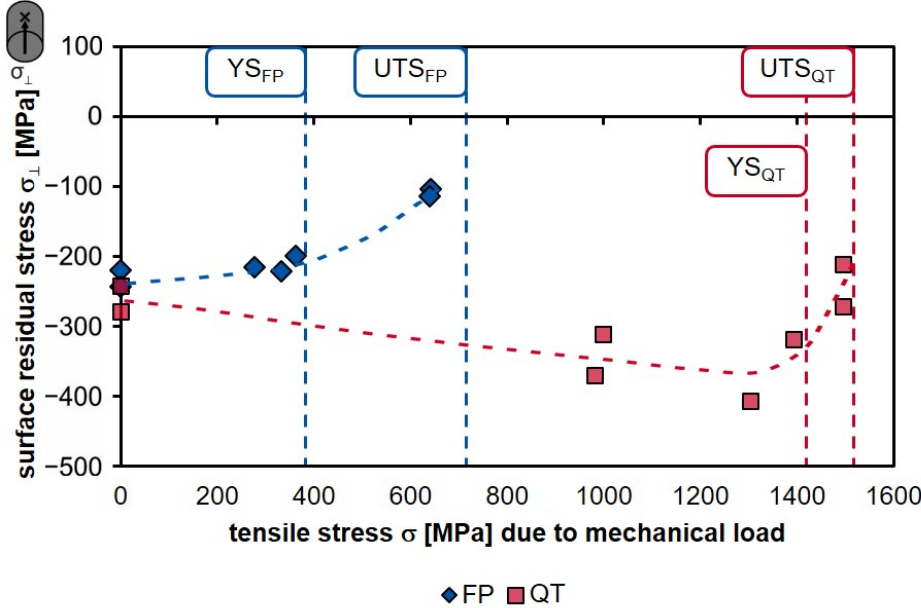
Figure 13. Surface residual stress transverse to grinding direction of grind-strengthened specimens as a function of the load stress in the tensile test.